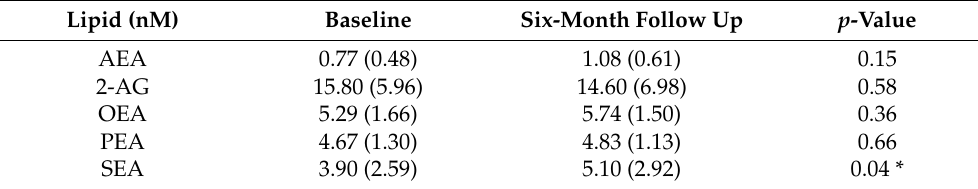
Table 3. Mean (SD) concentrations of arachidonoylethanolamide (AEA), 2-arachidonoylglycerol (2- AG), palmitoylethanolamide (PEA), oleoylethanolamide (OEA), stearoylethanolamide (SEA) before the interdisciplinary multimodal rehabilitation program and at a six-month follow-up. * Indicate statistically significance. Lipid (nM) Baseline Six-Month Follow Up